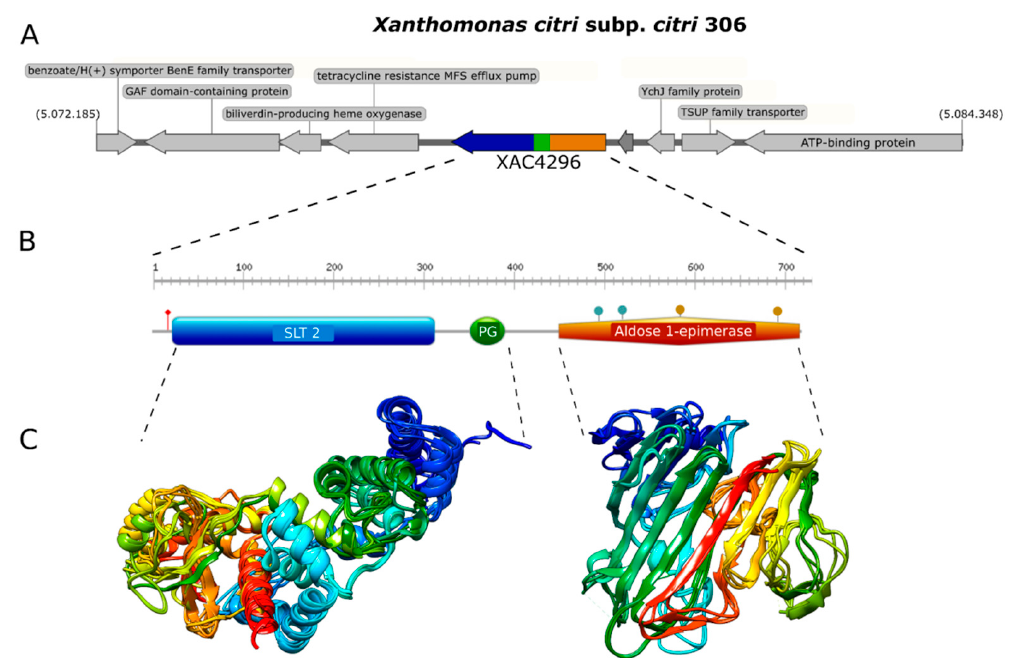
Figure 1. Genome context, protein domain, and structure of XAC4296. ( A ). Genome context of XAC4296 from X. citri genome. ( B ). Protein domain and structure of XAC4296. XAC4296 has 720 aa with the LT domain associated with 3B family: Transglycosylase SLT domain (SLT_2) (IPR031304.) and Peptidoglycan binding (PG_binding_1) (IPR002477) domains, and the Aldose 1-epimerase (IPR015443) domain. ( C ). Molecular modeling cartoon representation of the LT and epimerase XAC4296 domains.